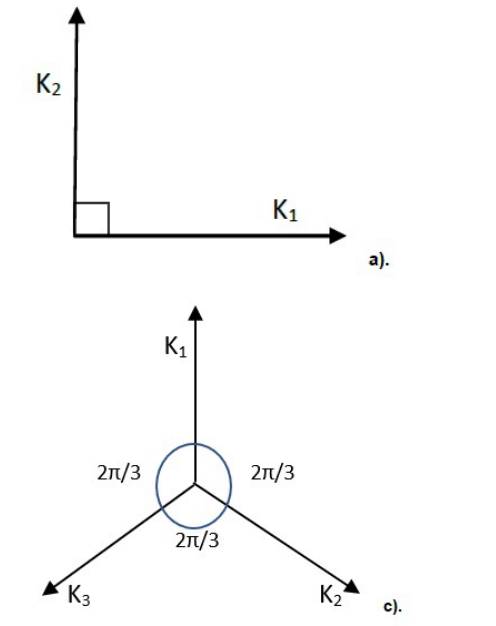
Figure A1. Basic wavevectors of disturbances. Panel ( a ) square/rolls lattice, ( b ) rhombic lattice, ( c ) hexagonal